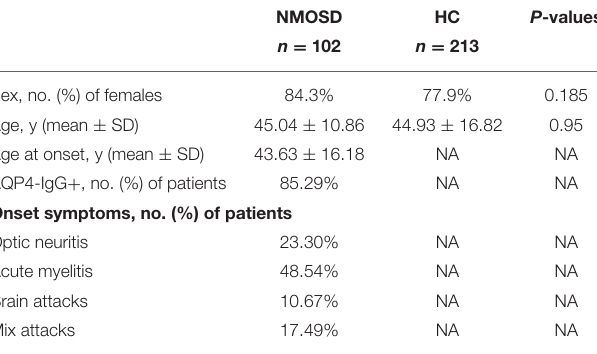
TABLE 2 | Demographics and clinical characteristics of participants for IRAK1